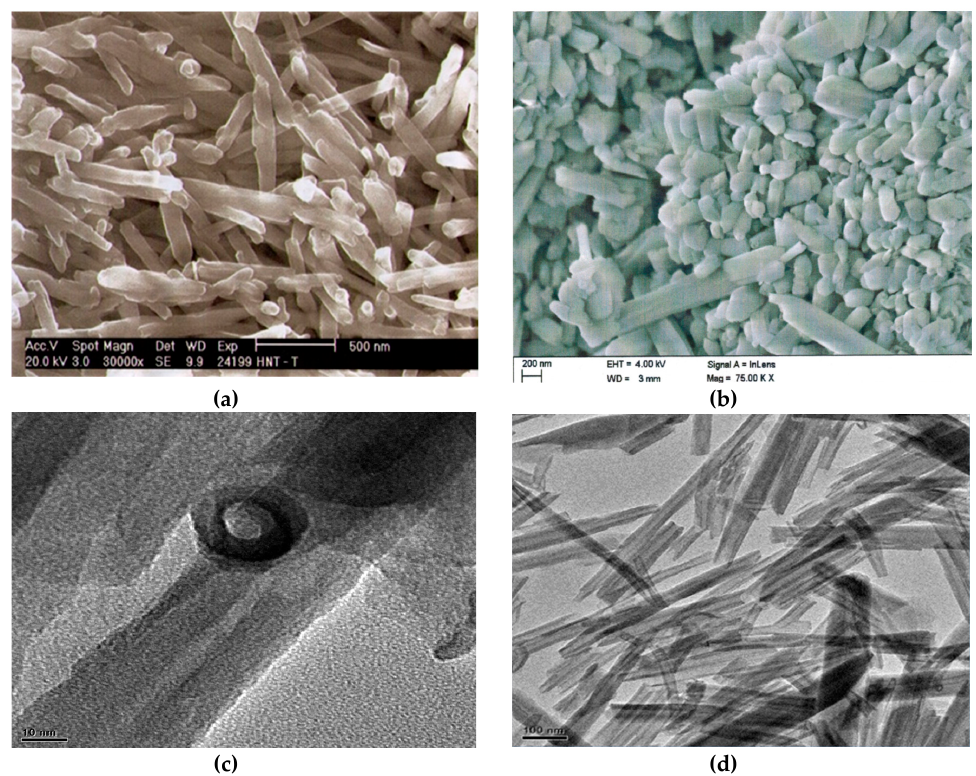
Figure 1. Scanning electron microscope images of halloysite nanotubes ( a ) HNT-MF4; ( b ) HNT-MF2; ( c ) and ( d ) HNT-MF7.